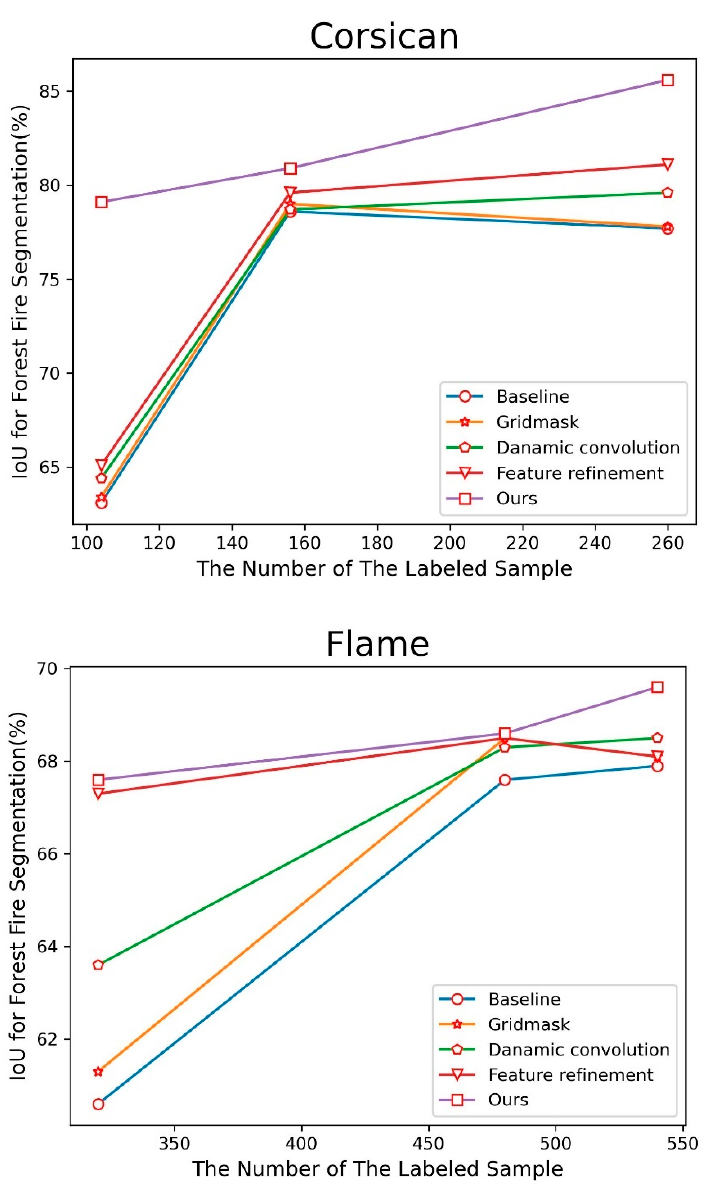
Figure 12. IoU for forest fire segmentation under various numbers of labeled images. The loss reflects the error between the actual and predicted values, and the loss trend reflects the state of the model learning. It is expected that both the training loss and the